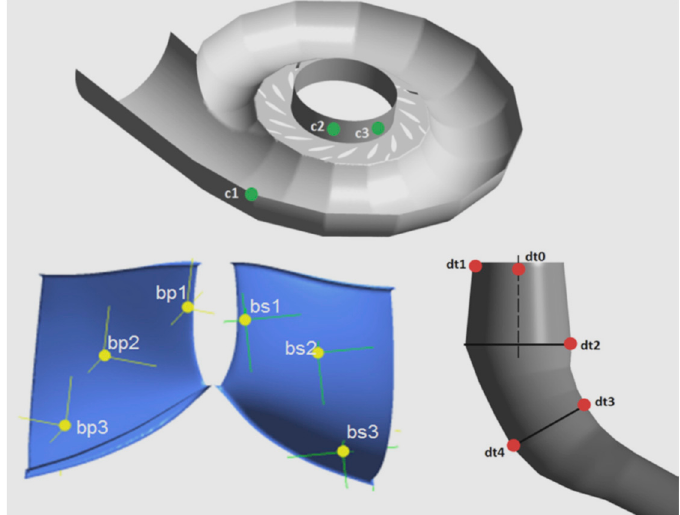
Figure 15. Pressure recording locations in spiral casing, runner blade, and draft tube [42].